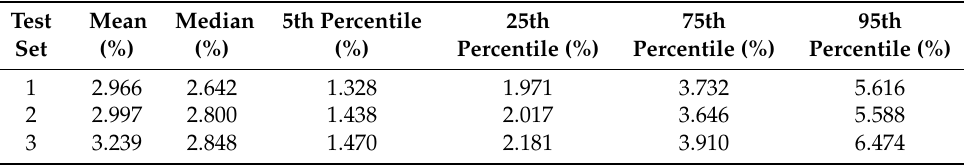
Table 4. Statistics description of the absolute error in each test